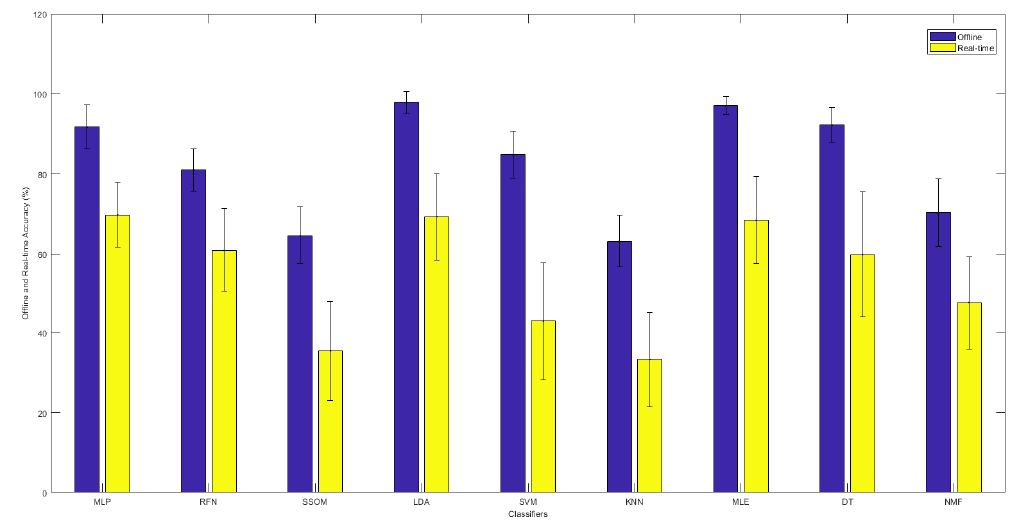
Figure 3. The offline and real-time average accuracies between classifiers, with their standard deviations in the top-center of each bar over 15 subjects.